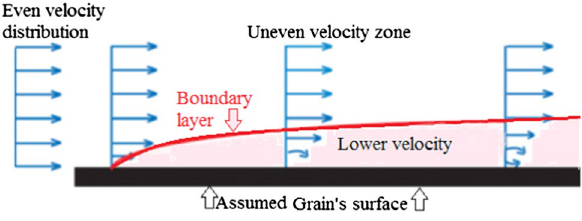
Fig. 3 Schematic illustration showing possible effects of boundary layer on the velocity